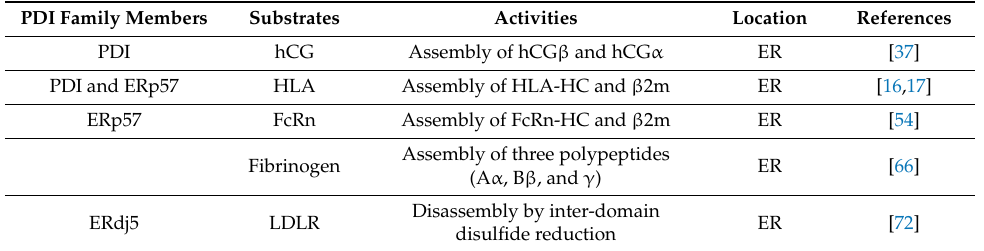
Table 1. Protein assembly and disassembly by PDI family